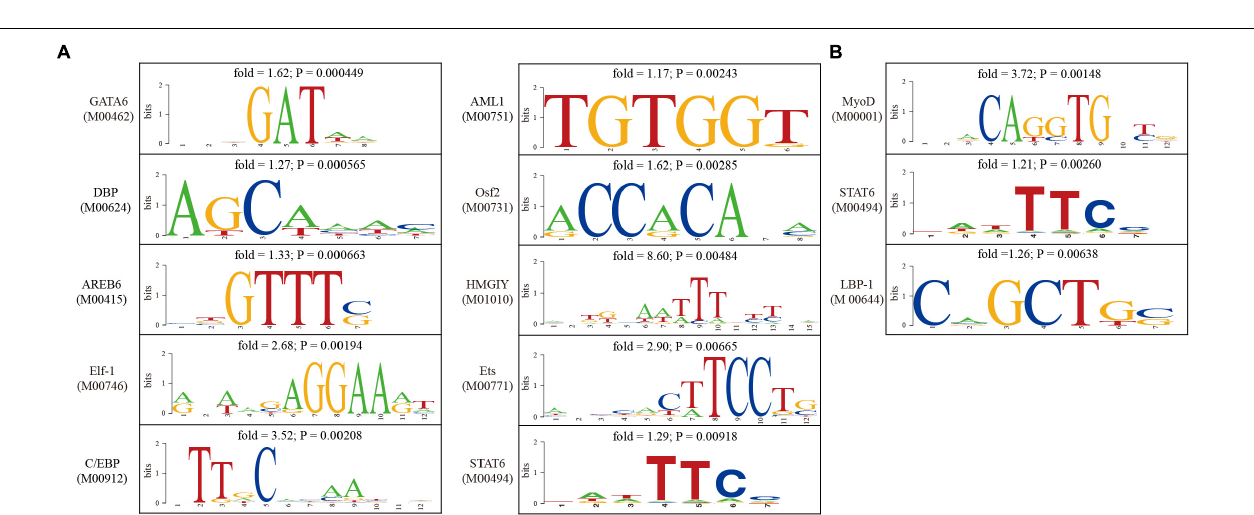
FIGURE 4 | Gene network underlying differentially expressed genes. (A) The structure of the gene–gene interaction network. Up-regulated genes were colored in red and down-regulated genes were colored in green. The 16 hub genes were showed in the center of the network. Hub genes were defined as genes with degree values exceeding the mean plus two standard deviations. (B) Degree distribution of the network.